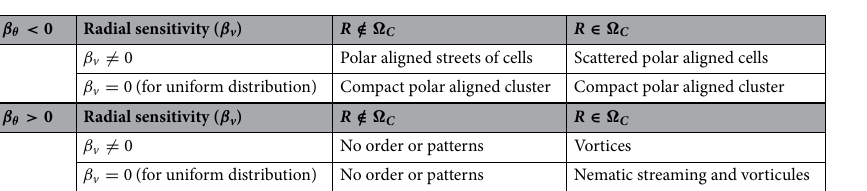
Table 1. Qualitative description of the observed patterns for different angular sensitivity and interaction radius regimes, as well as radial sensitivity.The patterning regime (cid:31) C is the blue area in Fig. 4a,b.